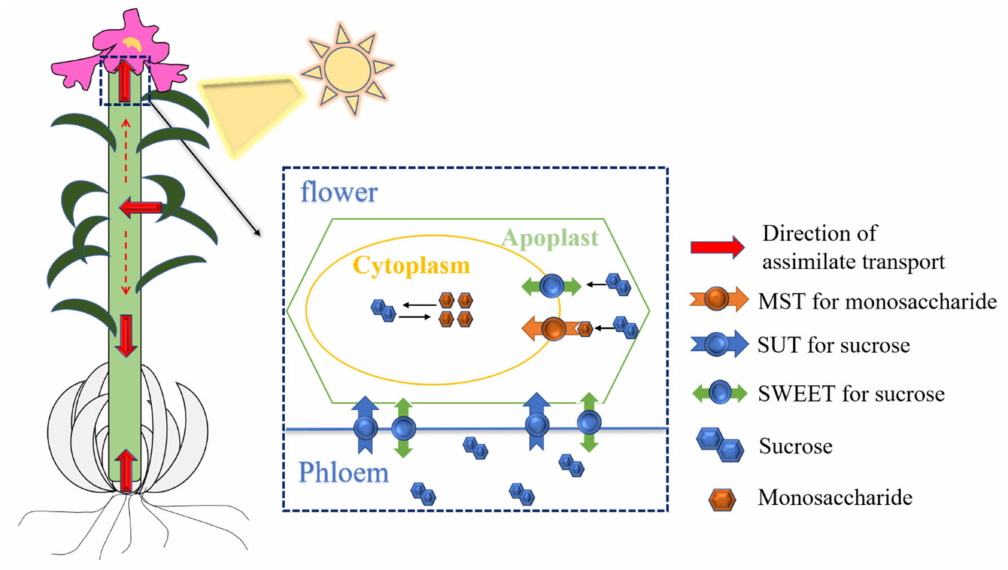
Figure 5. A hypothetical model on the molecular regulation of the allocation and transport of assimilates in lily during